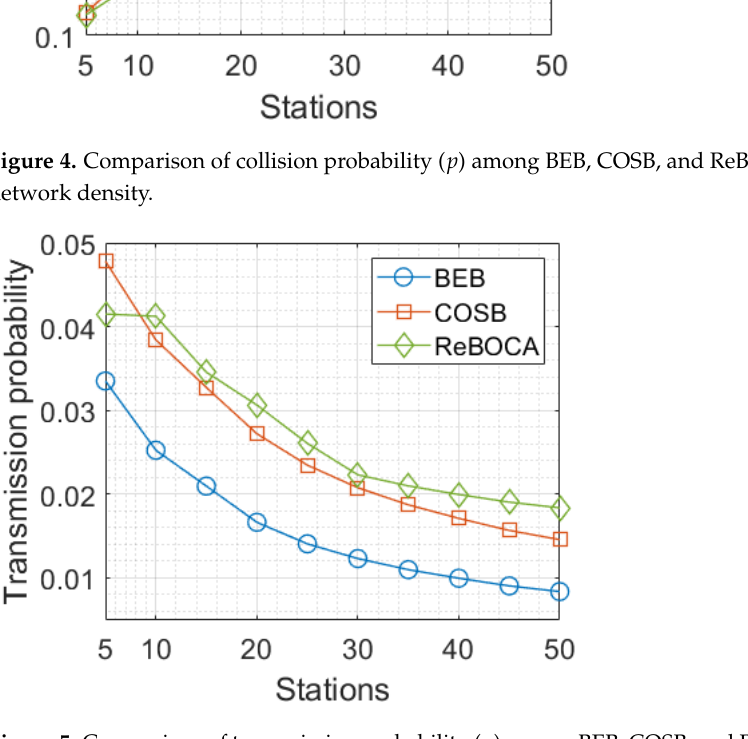
Figure 5. Comparison of transmission probability ( τ ) among BEB, COSB, and ReBOCA due to change in network